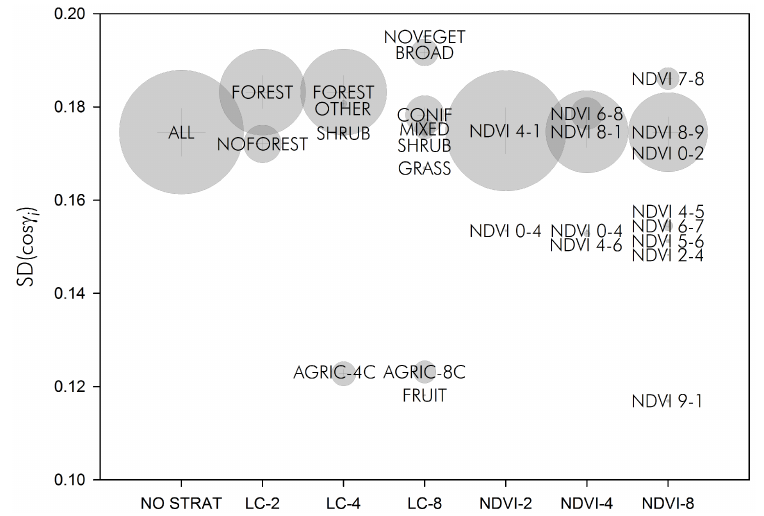
Figure 5. SD of cos γ i for each stratum. Circle sizes represent the proportion of each stratum in the study